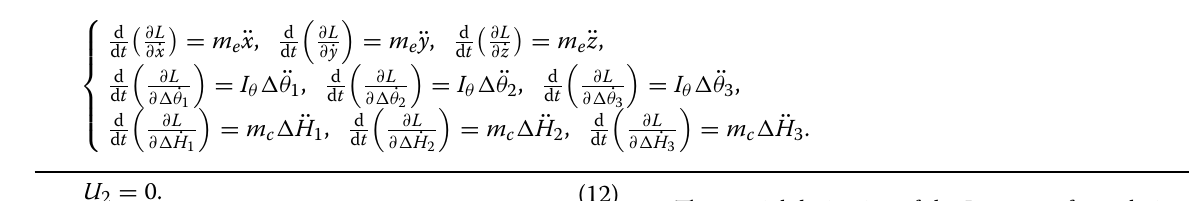
The partial derivative of the Lagrange formulation with regard to the generalized coordinates can be derived as